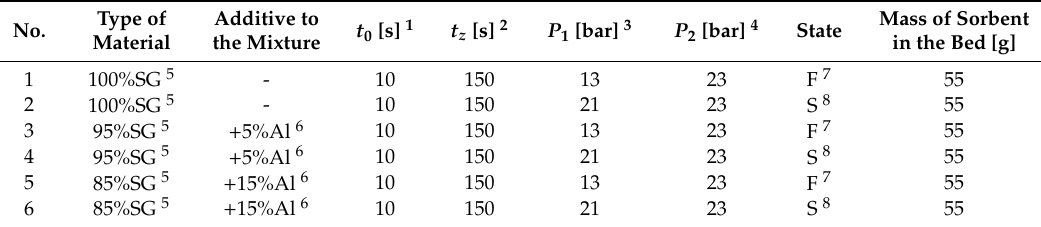
Table 1. Initial research conditions.